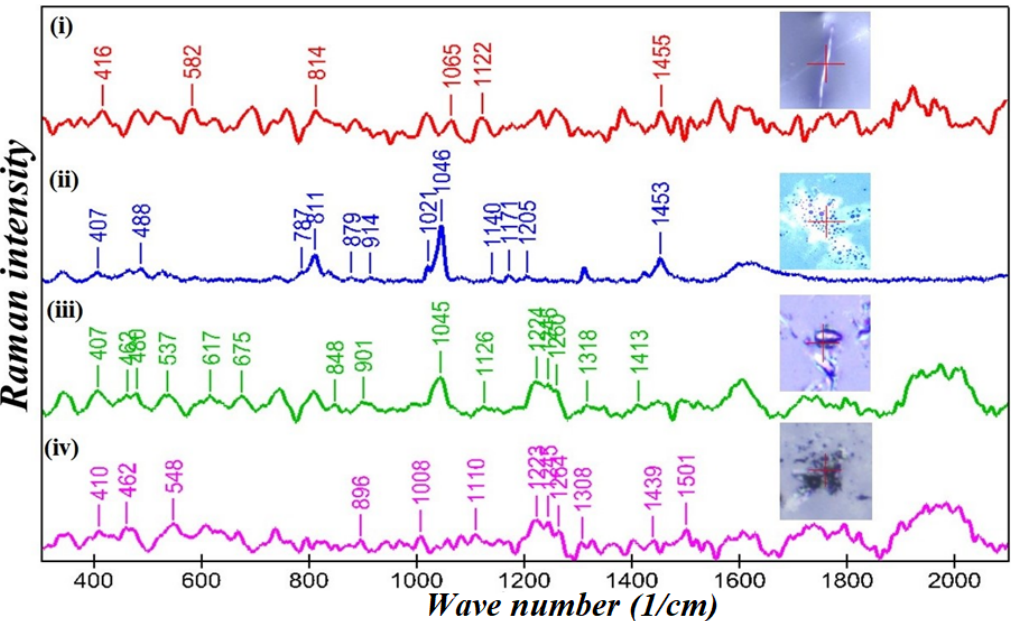
Figure 9. Comparison of the surface enhanced Raman spectra of Rhizopus arrhizus sporangiospores treated with PEI-f-Ag-NPs for 24 h. ( i ) Raman spectrum of mycelium, ( ii ) SERS spectrum of freshly harvested sporangiospores, ( iii ) SERS spectrum of sporangiospores incubated with PEI-f-AgNP-1, and ( iv ) SERS spectrum of sporangiospores incubated with PEI-AgNP-2 with corresponding confocal Raman microscopic photographs (inset). Band peaks are assigned for matched biomolecules.